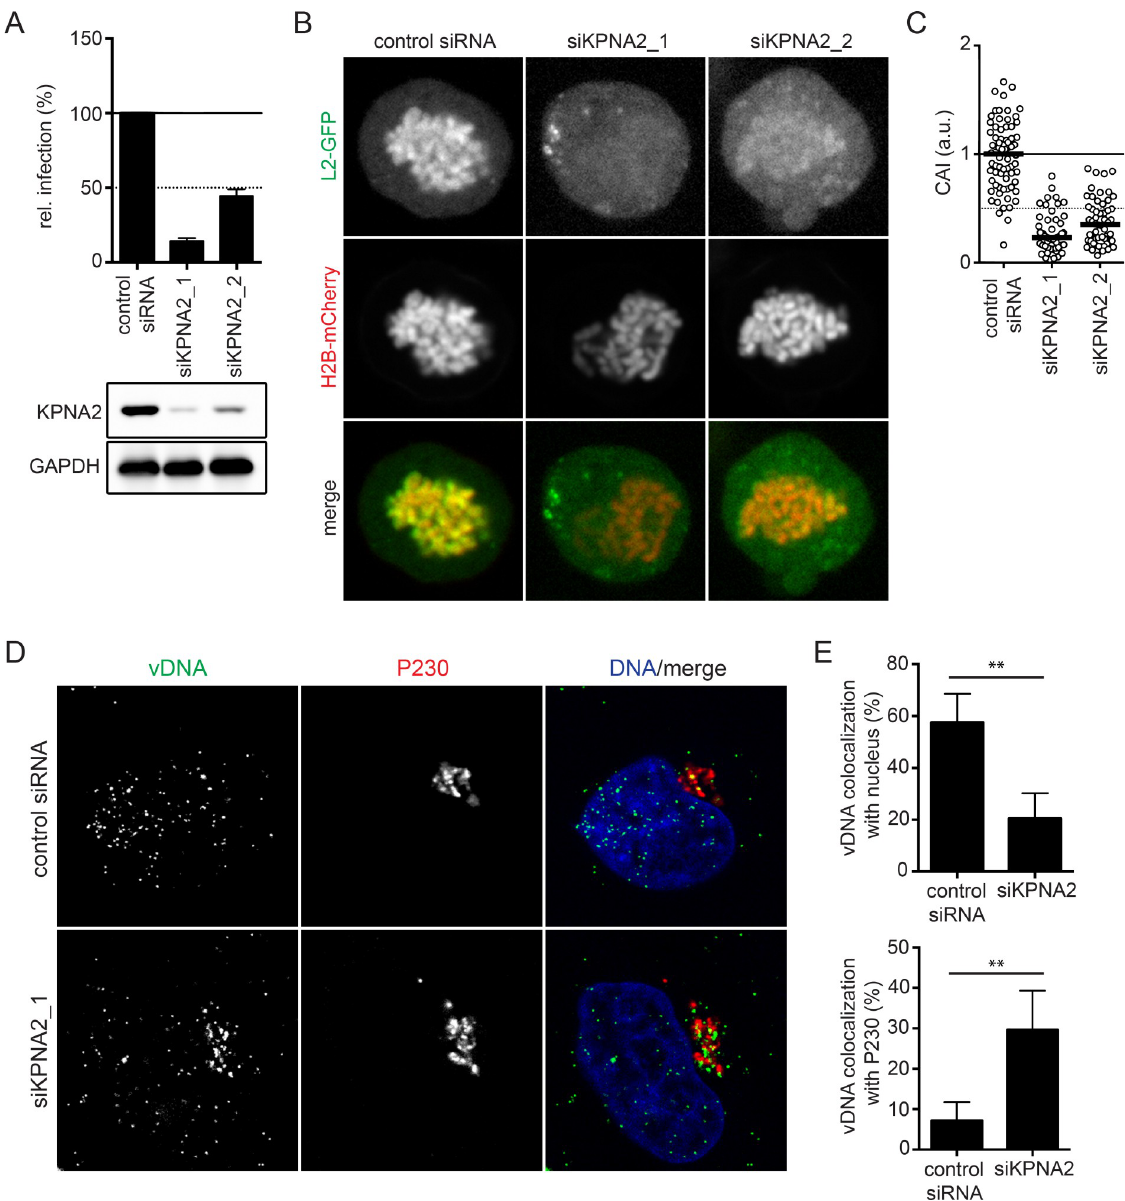
Fig 5. KPNA2 facilitated HPV16 infection and L2/vDNA nuclear import. (A) RNAi of KPNA2 by two individual siRNAs was followed by HPV16-PsV infection. Infectivity was scored based on cells expressing GFP over total cells. The infectivity was normalized to control siRNA transfected cells as relative (rel.) infection. Error bars indicate the SD of three independent experiments. (B) A L2 chromosomal association assay after KPNA2 depletion in HeLa Kyoto_H2B-mCherry_L2-GFP cells was performed as in Fig 2B. (C) CAI of panel B. At least 50 cells were analyzed in three independent experiments, and the median was indicated by the black bar. (D) HPV16 vDNA localization upon RNAi of KPNA2. HeLa cells were depleted of KPNA2 by siRNA transfection, followed by EdU-labelled HPV16 infection for 20 hours. P230 and Hoechst-33258 were stained to indicate TGN and nucleus, respectively. Confocal images depict median slices. (E) Co-localization of vDNA with the nucleus or P230 was quantified using IMARIS. At least 40 cells were analyzed in three independent experiments. Error bars indicate the